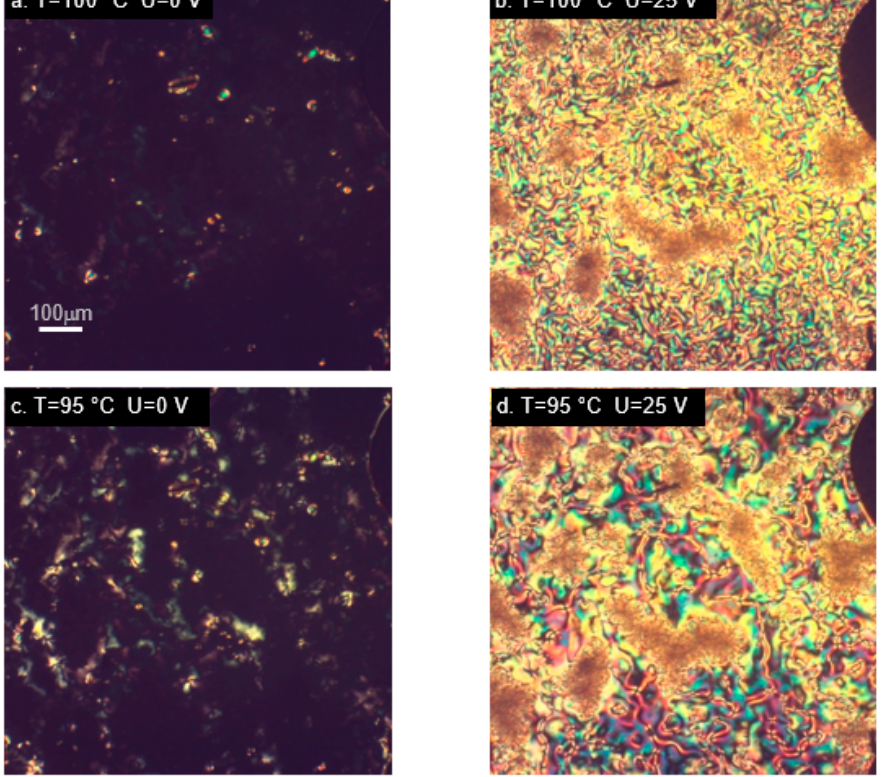
Figure 6. Microphotographs (in cross-polarized light) of compound AU12 in nematic ( a , b ) and smectic phase ( c , d ), showing alignment changes due to electric field. Sample placed in cell with omeotropically-ordering layer.